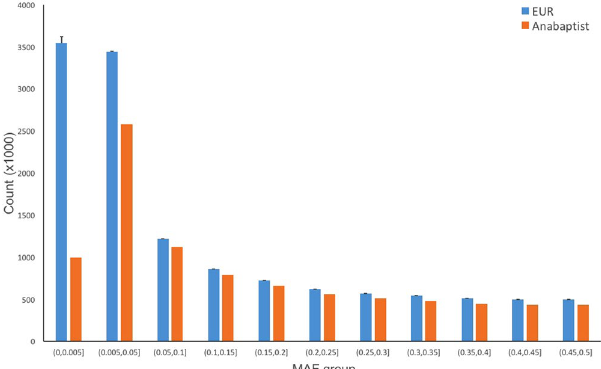
Figure 4. Variant counts by MAF group. The error bars for EUR (Europeans) were estimated based on 10 sub- samples of 102 randomly-selected Europeans in the 1000G